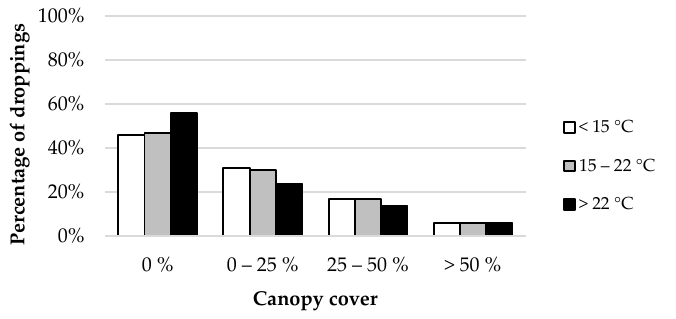
Figure 11. Effect of ambient temperature-canopy cover interaction in the distribution of dung.